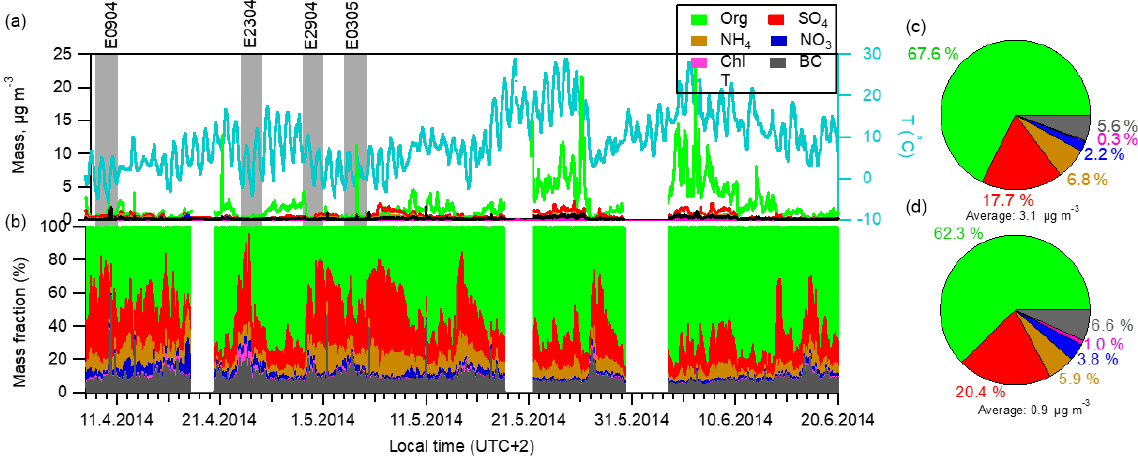
Figure 1. Time series and chemical composition of aerosol species determined by AMS in the campaign. The gray bars mark the four new particle formation events that this study focuses on. (a) Ambient temperature ( T ) and time series of aerosol mass concentrations. (b) Mass fractions of each aerosol component to the total aerosol mass concentrations. (c) Right pie charts show the average chemical composition for the campaign periods and (d) for the four new particle formation